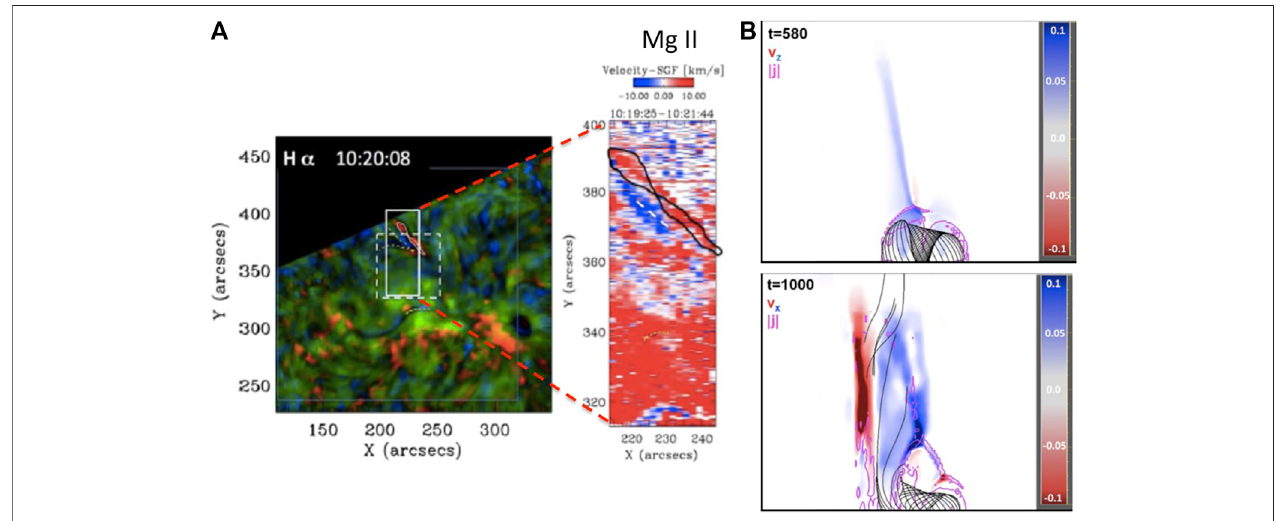
FIGURE 7 | Jet observation (A) in H α with the Meudon MSDP (left panel) in Mg II with the IRIS (middle panel) on 30 March 2017: Dopplershift map (blue and red) combinedwithH α intensity(yellowandgreen)and therelated DopplershiftrastermapinMgII(fromRuanet al.(2019). (B) Dopplermapsobtainedfortwotimes inthe3D MHD simulation of a twisted jet showing that the opposite sides of the jet have opposite (red/blue) Dopplershifts [from Pariat et al.